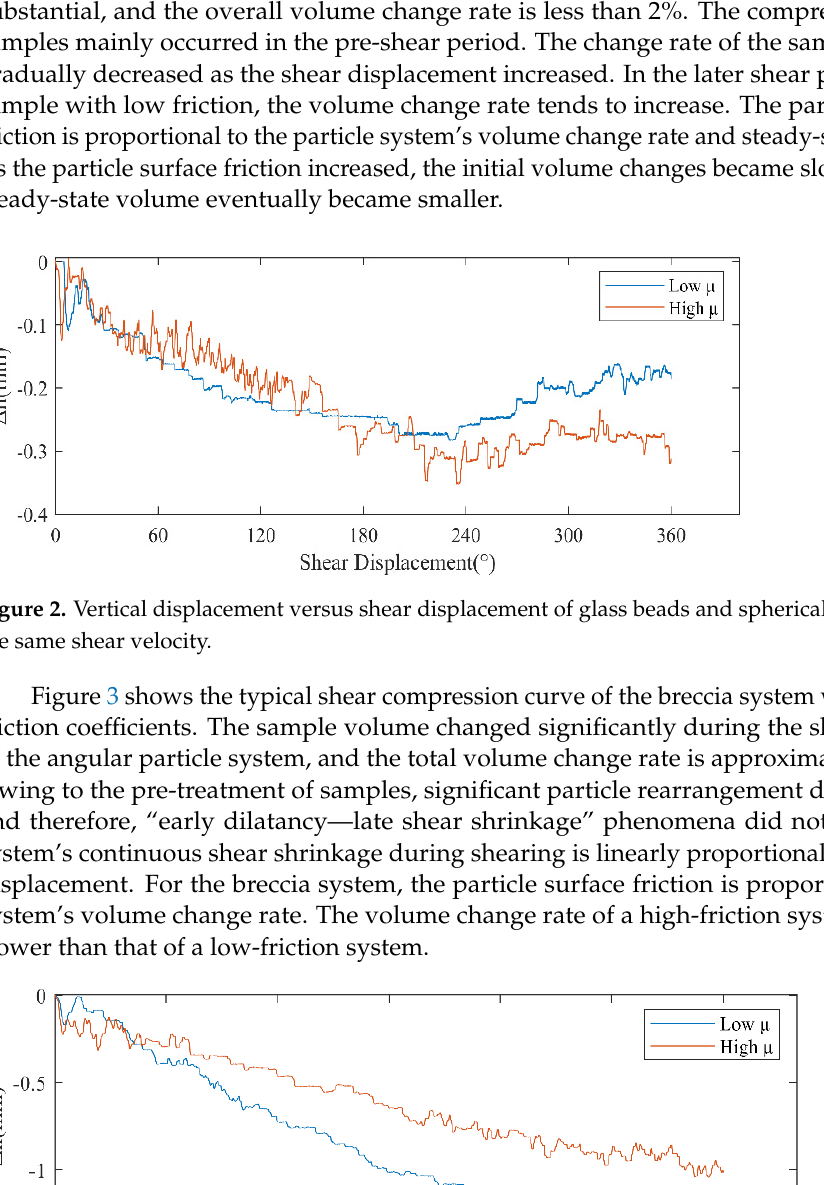
at the same shear velocity.